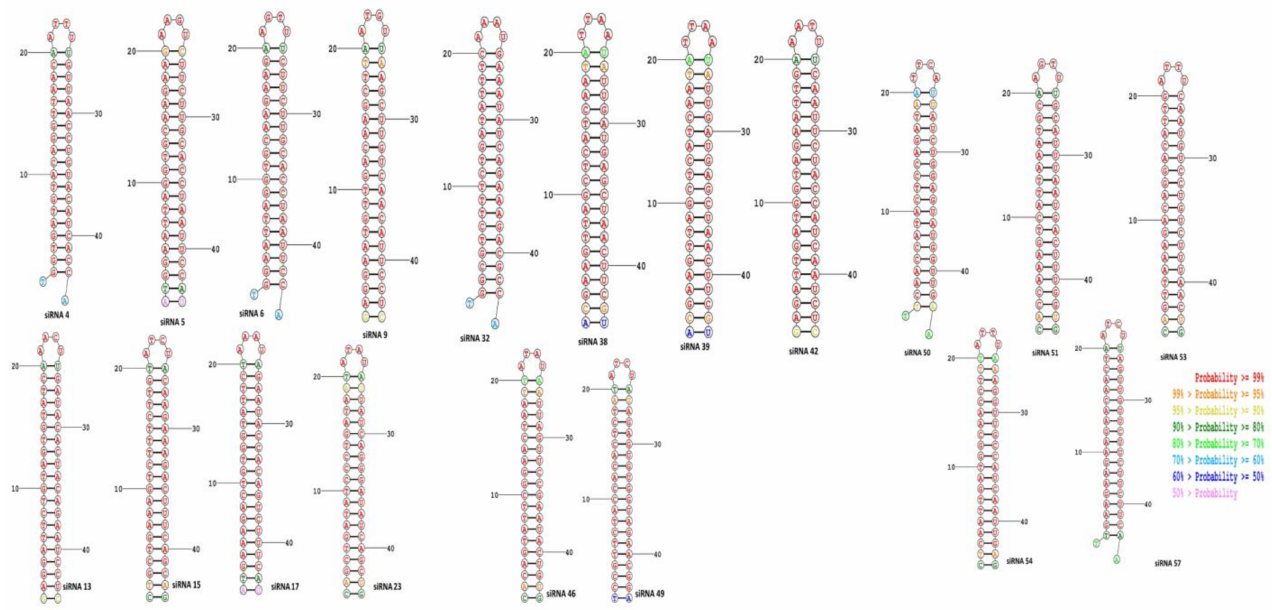
Figure 2. Secondary duplex structures between the siRNA candidates and their respective mRNA target